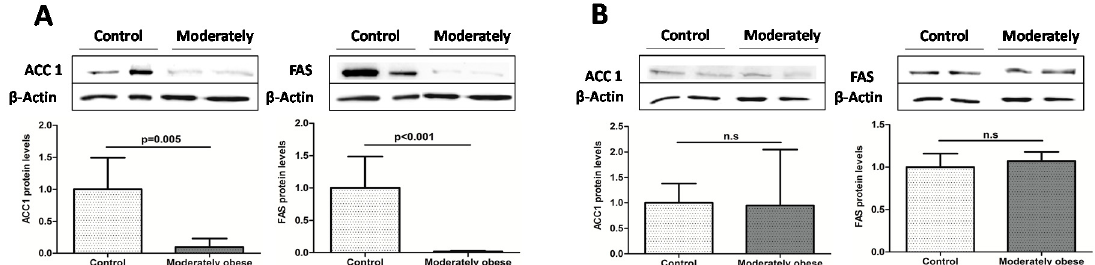
Figure 3. Western blot analysis of the main lipogenic enzymes in subcutaneous ( A ); and visceral ( B ) adipose tissue of moderately obese patients. Bar graphs show the quantification of ACC1 and FAS bands normalized by values of β -actin ( n = 12 for each group). Student’s t -test was used to determinate differences between groups. Data are expressed as mean ± SD. ACC1, Acetyl-CoA carboxylase 1; FAS, Fatty acid synthase.